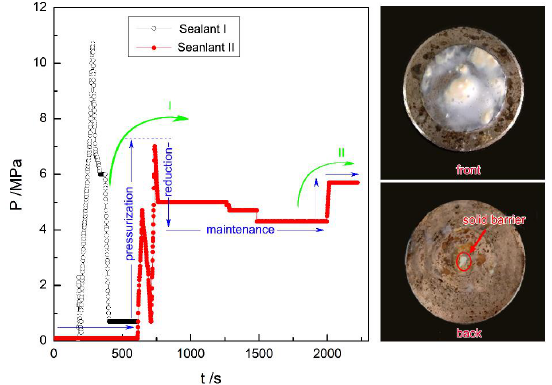
Figure 7. Comparison of dynamic sealing curves of Sealant I and Sealant II ( left ) and solid barrier formed by Sealant II in a 0.6 mm × 2.0 mm × 10 mm crack defect ( right ). The right provides the solid seals formed in the crack’s front ( top ) and back ( bottom ).